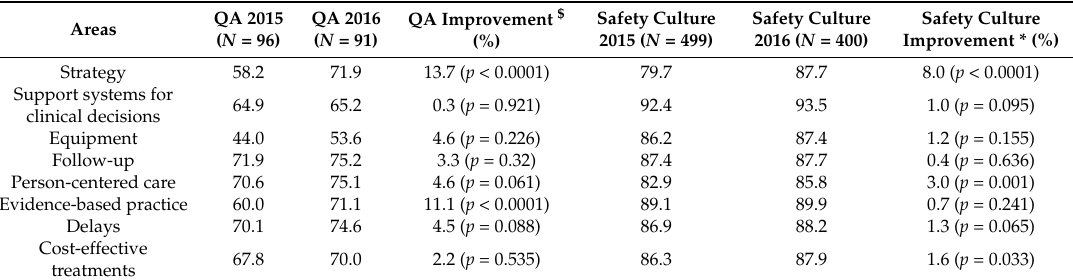
Table 1. Response trends and results comparison of the Safety Culture and Quality Assurance measurements assessment.